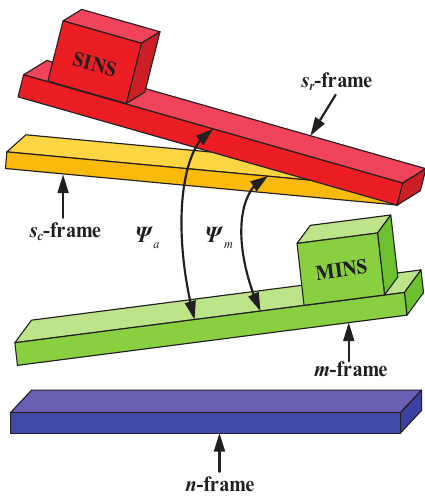
Figure 2. Sketch map of misalignment angles between the main INS (MINS) and slave INS